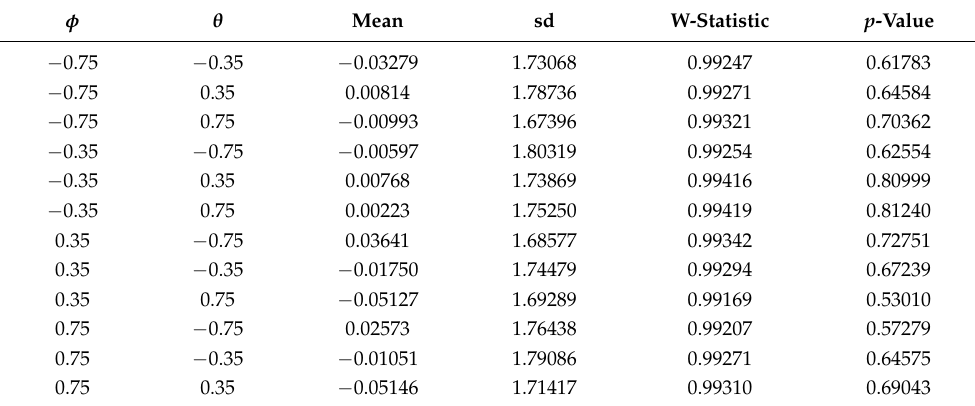
Figure 1. Density plots of bootstrap resamples of size 5000 for the centered residuals ˜ e t . Table 1. Mean values, standard deviations, and the Shapiro–Wilk test results for the bootstrap resamples drawn in Figure